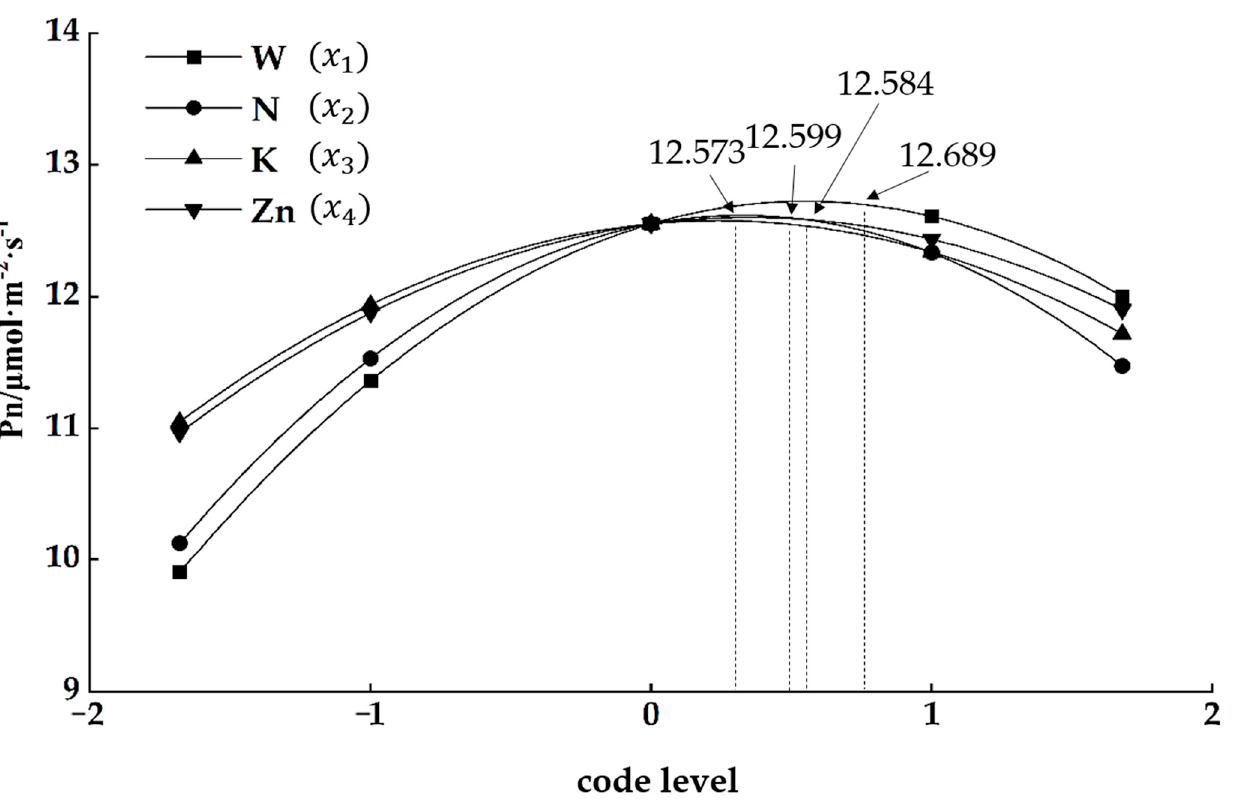
Figure 2. Effect on net photosynthetic rate ( Pn ) of irrigation amount (W), nitrogen application amount Figure 2 . Effect on net photosynthetic rate ( 𝑃𝑛 ) of irrigation amount ( W ), nitrogen application (N), potash application amount ( K ), and zinc application amount amount ( N ), potash application amount ( 𝐾 ), and zinc application amount ( Zn ).